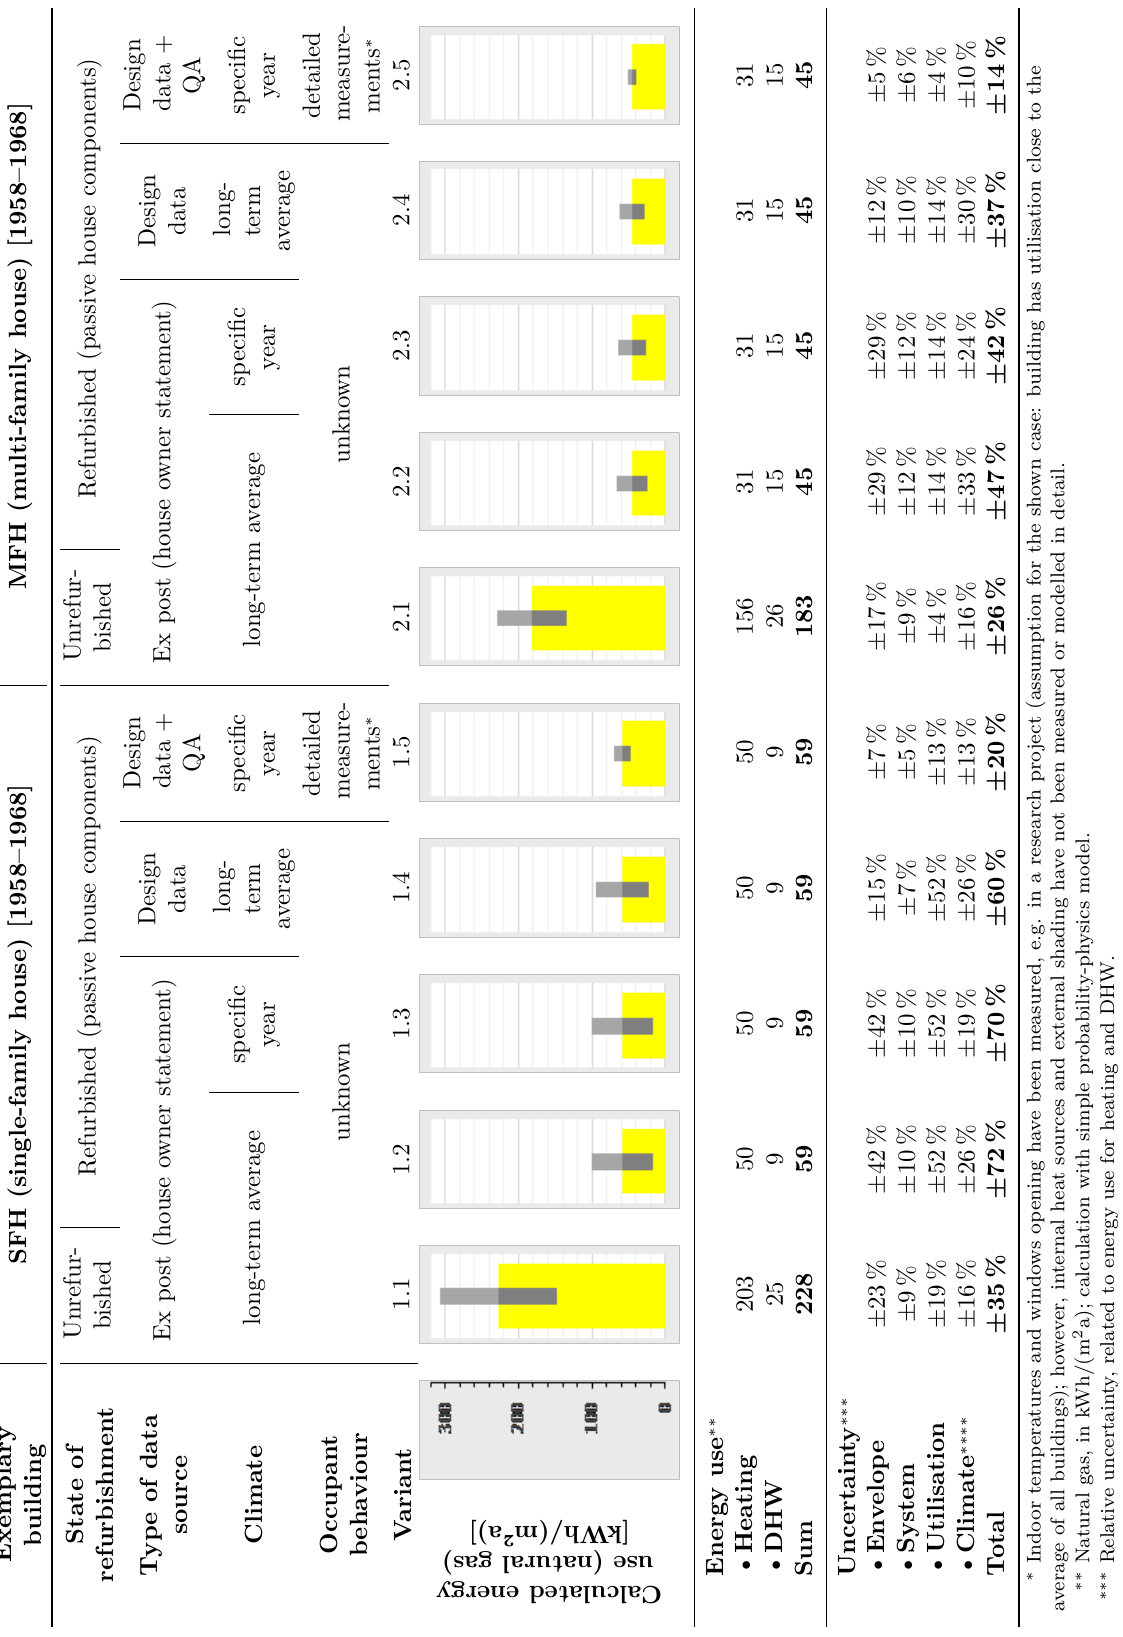
Table 3. Estimation of the actual energy consumption before and after deep refurbishment for two example buildings and assigned uncertainty, depending on the type of data source and measurements (A PDF demonstrating the calculation flow for the 10 building variants can be viewed in the supplemental document mentioned above